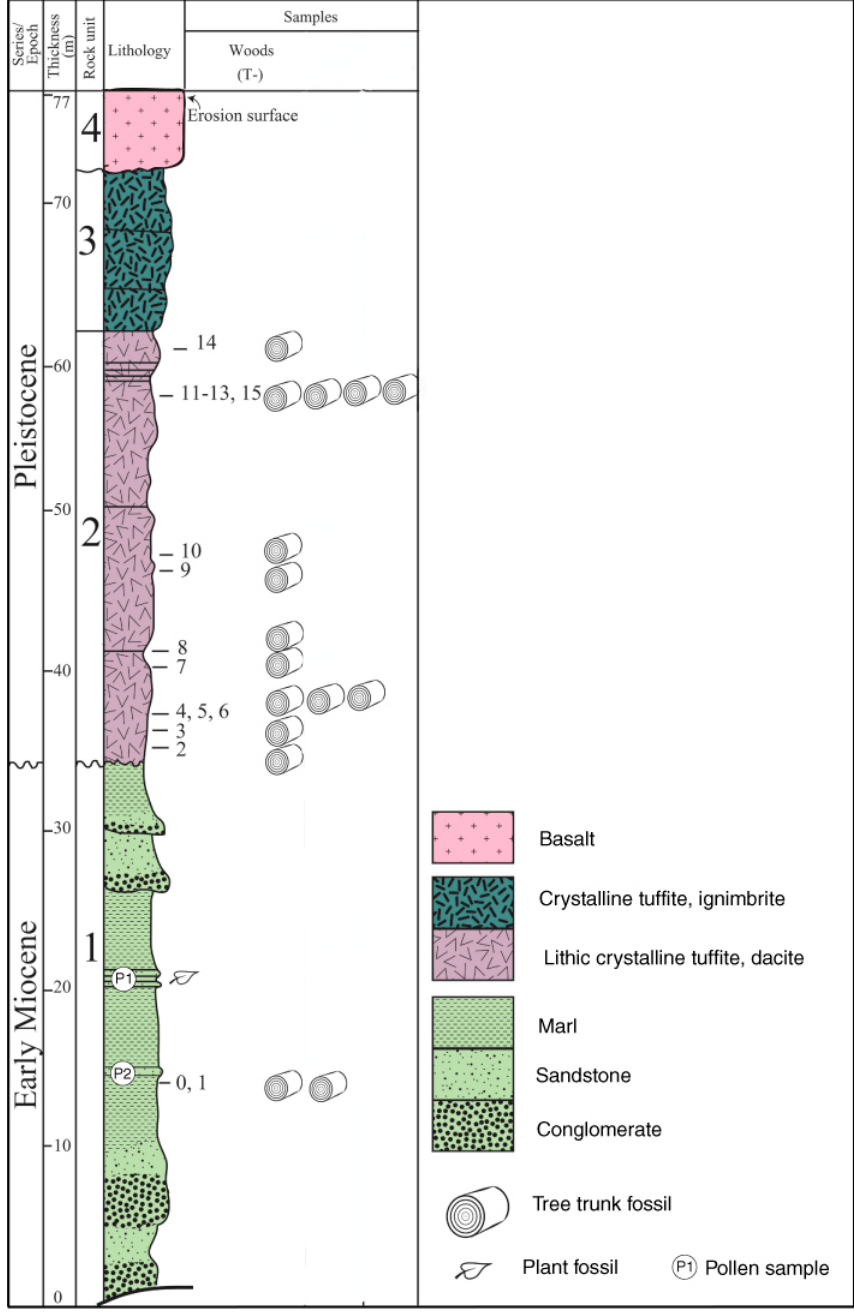
Figure 3. Stratigraphic column showing position of individual fossil logs.